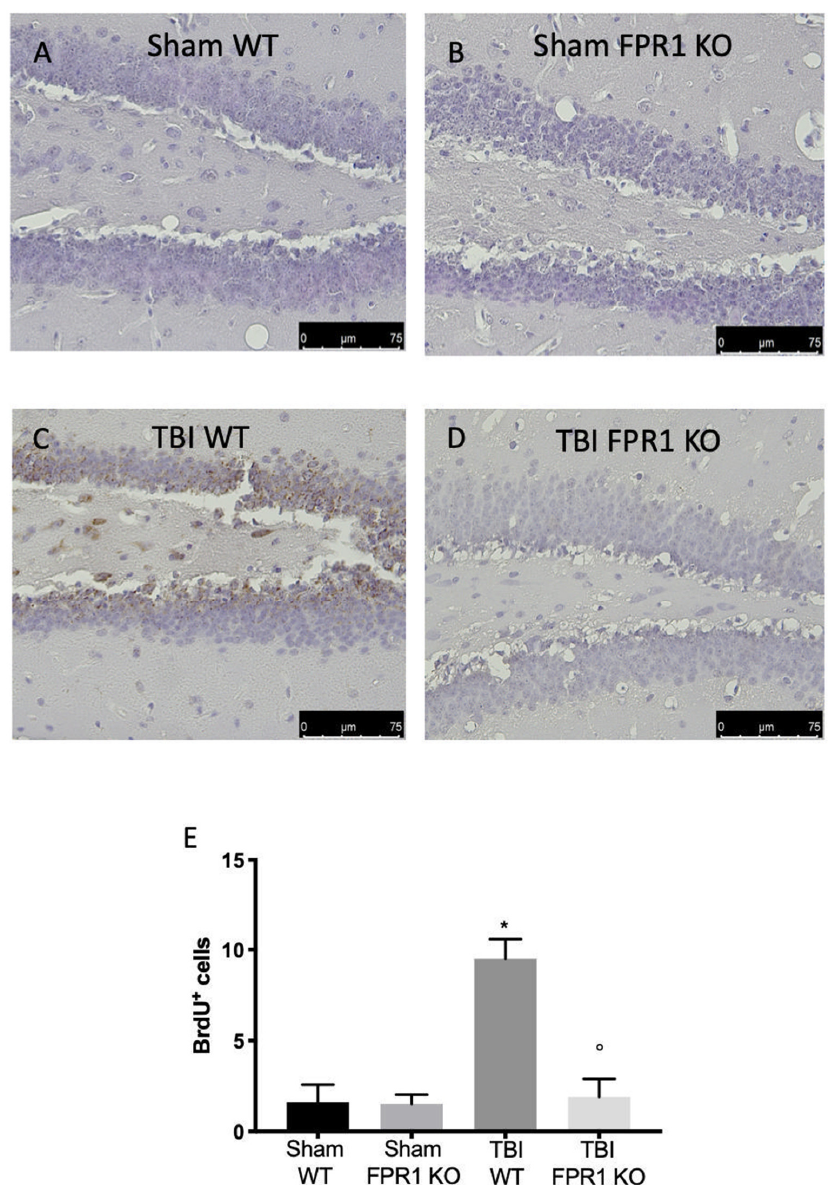
Figure 13. Effect of the absence of Fpr1 on neurogenesis: Immunohistochemical analysis shows an increased number of BrdU-positive proliferating cells in the Dentate Gyrus of WT animals subjected to TBI four weeks after injury ( C ) compared to the Sham WT group ( A ) and Sham Fpr1 KO group ( B ) Fpr1 KO animals four weeks after TBI shows significantly less BrdU-positive proliferating cells ( D ); see the densitometric analysis ( E ) For the analyses, n = 5 animals from each group were employed. Results were analyzed by two-way ANOVA followed by a Bonferroni post-hoc test for multiple comparisons. Non-parametric data were analyzed with Fisher’s exact test. * p < 0.05 vs. Sham WT; ◦ p < 0.05 vs. TBI WT. scale bar 75 µ